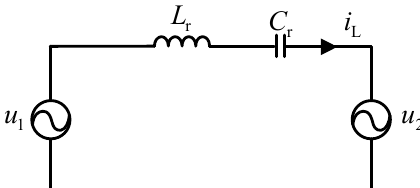
Figure 2. Series-connected resonant dual-active-bridge converter equivalent circuit diagram.